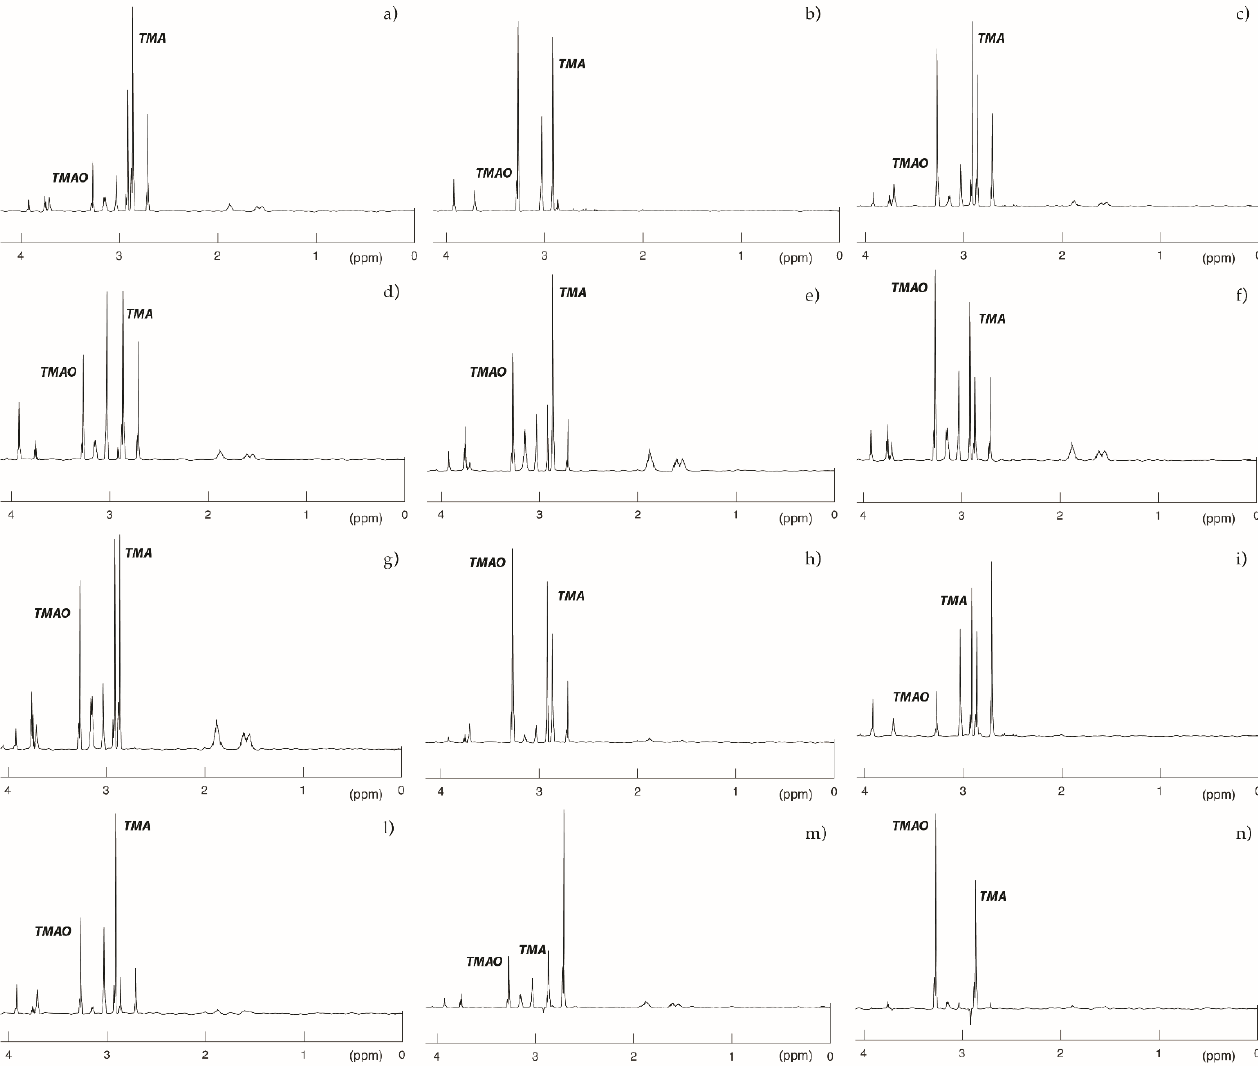
Figure 5. 500 MHz 1 H spectra of patients included in the study. Here, are represented the spectra resulting from 1 H NMR spectroscopy of the urine collected from patients showing a unique FMO3 variant haplotype. A healthy subject should present no peak for TMA and an intermediate peak for TMAO (not shown). Obtained results mostly confirmed genotyping and modelling analyses. ( a ) Patient 3; ( b ) Patient 10; ( c ) Patient 2; ( d ) Patient 9; ( e ) Patient 11; ( f ) Patient 6; ( g ) Patient 1; ( h ) Patient 8; ( i ) Patient 2; ( l ) Patient 4; ( m ) Patient 12; and ( n ) Patient 7. Metabolites peaks are assigned as follows: Trimethylamine-N-oxide (TMAO): 3.27 ppm; Creatinine (Cr): 3.06 ppm; Creatine (Cn): 3.04 ppm; Trimethylamine (TMA): 2.92 ppm; Dimethylamine (DMA): 2.73 ppm; and Citrulline (cit): 1.62 and 1.92 ppm.